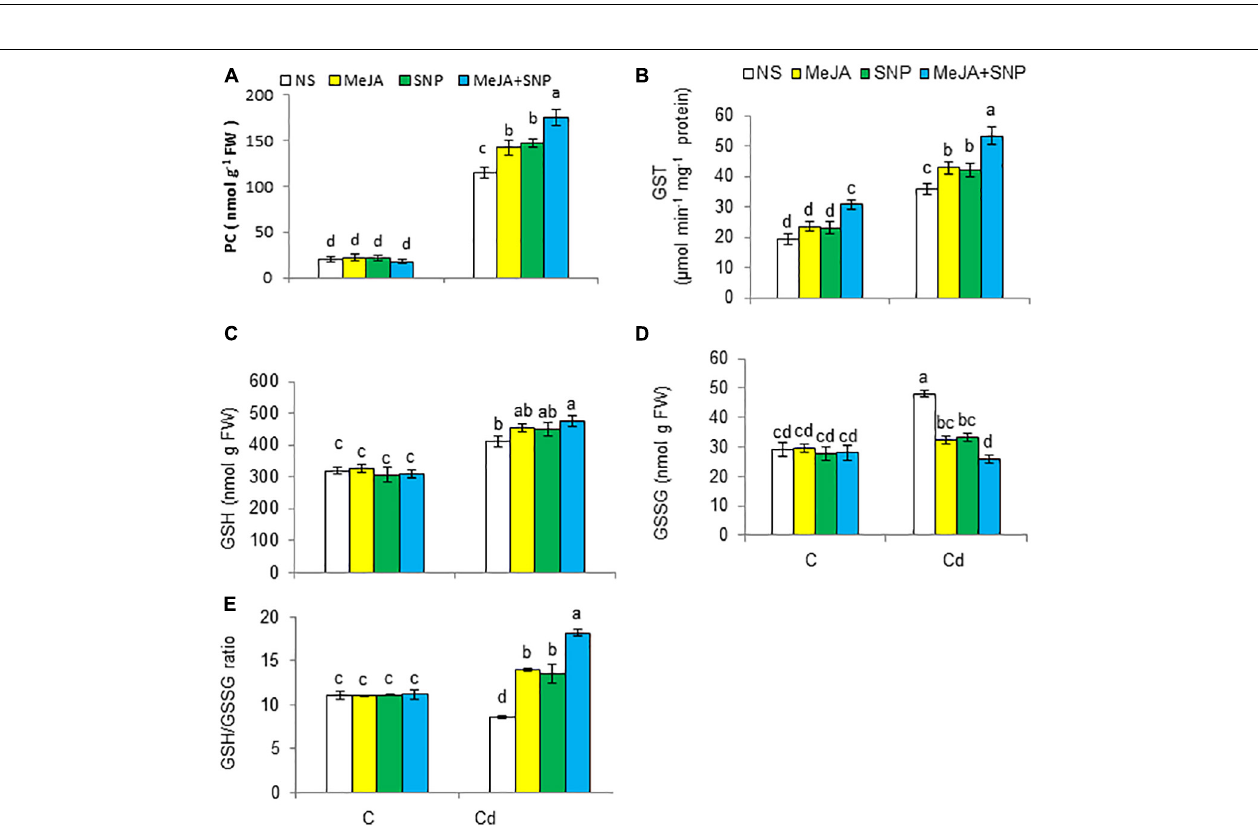
FIGURE 5 | Phytochelatin [PC (A) ], glutathione S -transferase [GST (B) ], reduced glutathione [GSH (C) ], oxidized glutathione [GSSG (D) ] on fresh weight (FW) basis, and GSH/GSSG (E) in wheat plants grown under control (C) and cadmium (100 µ M Cd) and sprayed with 10 µ M methyl jasmonate (MeJA) or 100 µ M sodium nitroprusside (SNP) alone or together (mean ± SE). Mean values carrying different letters within each attribute differ significantly ( P ≤ 0.05) based on Duncan multiple-range test.